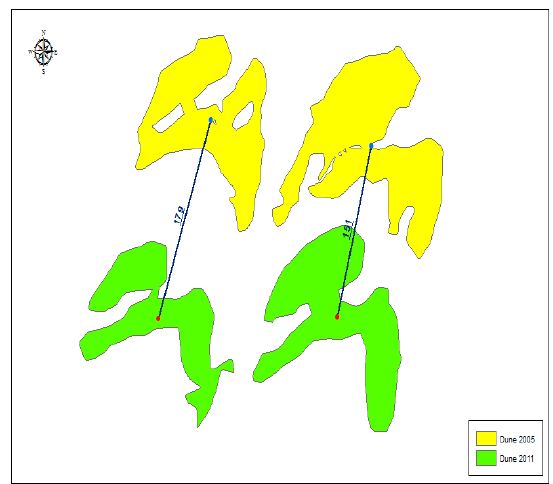
Figure 10: Rate of migration of the dune